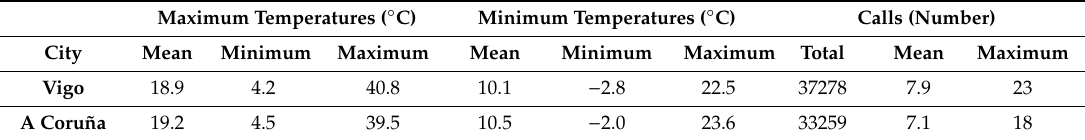
Table 1. Distribution of daily extreme temperature values and emergency calls (2005–2017).